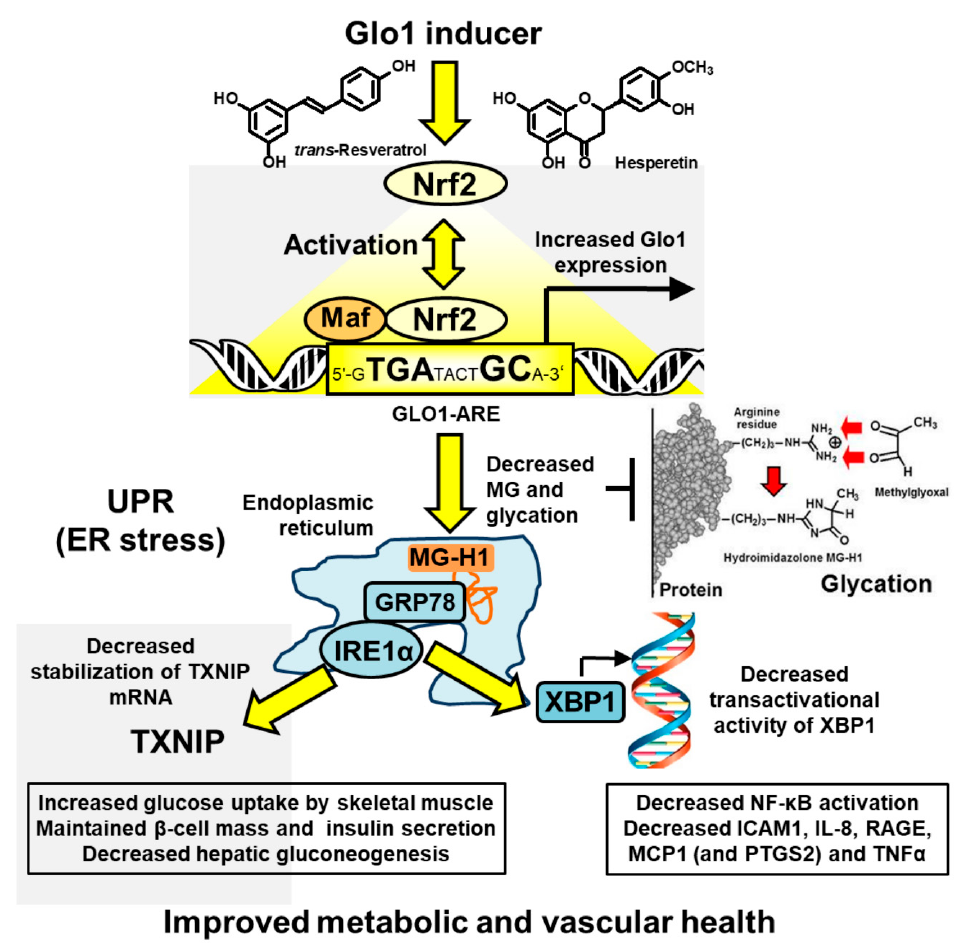
unfolded protein response. Key: yellow filled arrows—mechanism of health improvement; red filled Figure 3. Proposed mechanism of action of Glo1 inducer, tRES-HESP, through suppression of the unfolded protein re- sponse. Key: yellow filled arrows—mechanism of health improvement; red filled arrows—damaging processes sup- arrows—damaging processes suppressed. See text for pressed. See text for details.